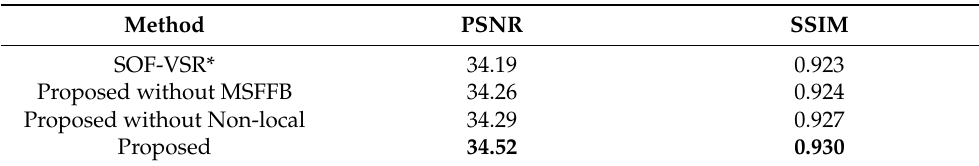
Table 1. PSNR and SSIM of the reconstruction results by × 4 scale of the proposed method and the variant method on the DAVIS-10 dataset. The result of the SOF-VSR* method is the result reproduced under the same operating environment of the proposed method, and the best results are shown in boldface.